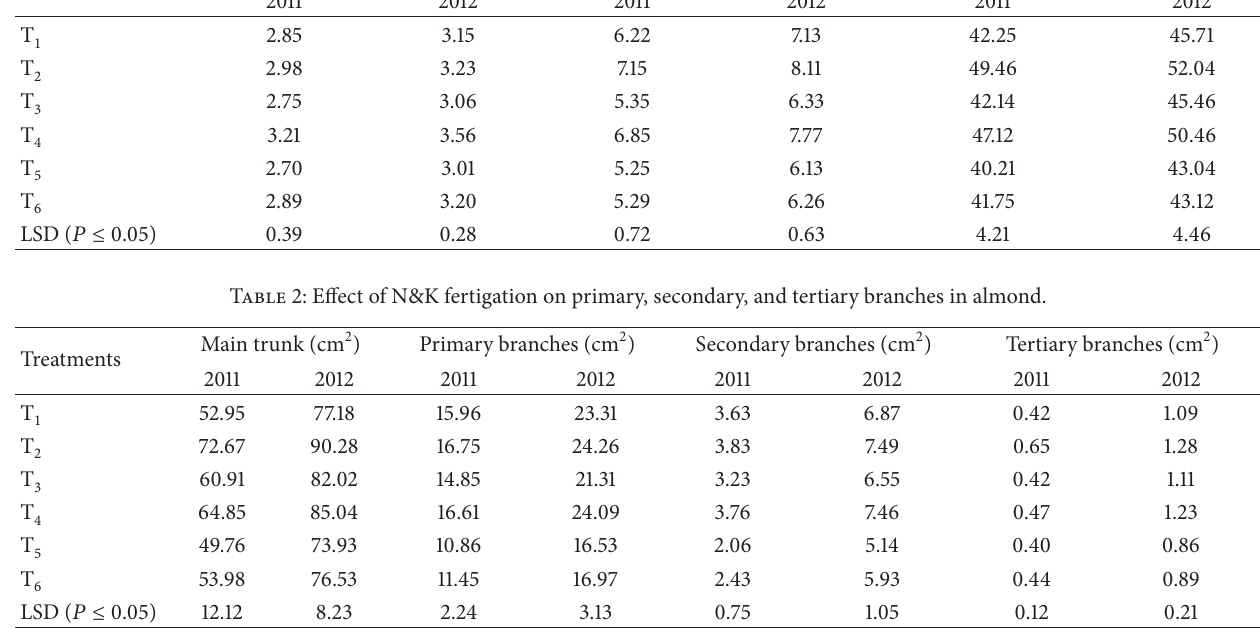
Table 1: Vegetative growth as influenced by N&K fertigation in almond. Treatments